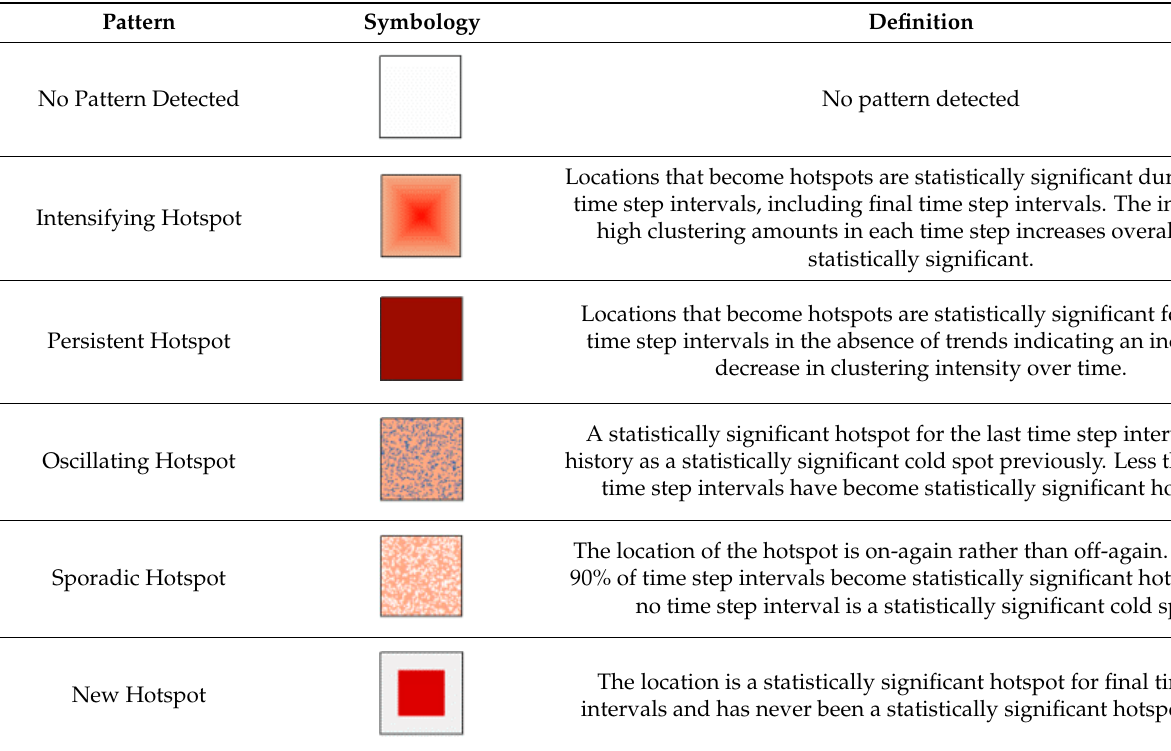
Table A1. Hotspot categories based on [44].